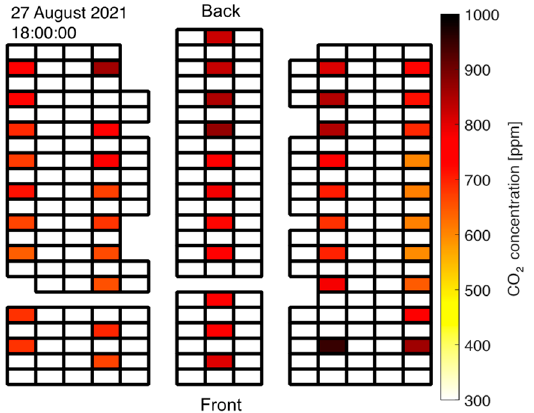
Figure 8. CO 2 concentration gradient from back to front during seating of students prior to exam in at-grade room.